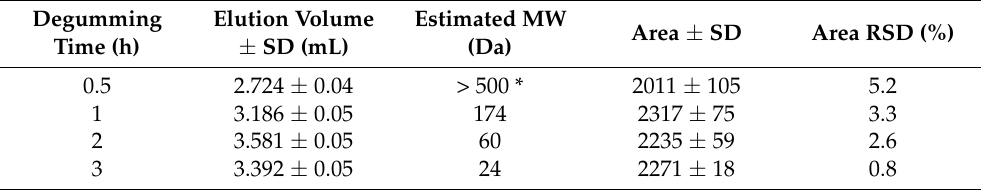
Table 4. Data from SEC-UV analysis of SF derived from different degumming times. Data are reported as mean values ± SD, n =